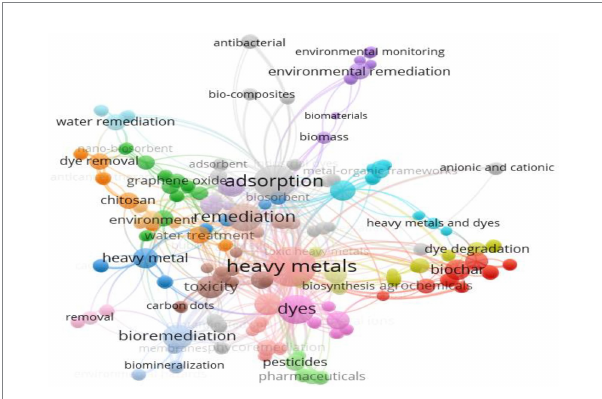
FIGURE 1 Network visualization of most frequently used keywords over time, as well as a clustering of the keywords’ citation